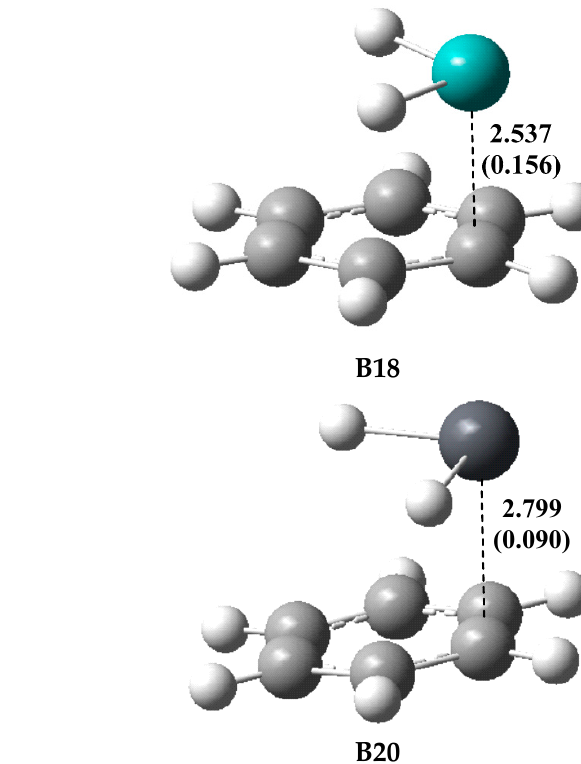
Figure 10. Optimized geometries of the type-B complexes involving C 6 H 6 at the MP2/aug-cc-pVDZ level, distances in Å, angles in °, and WBI values (in parenthesis).